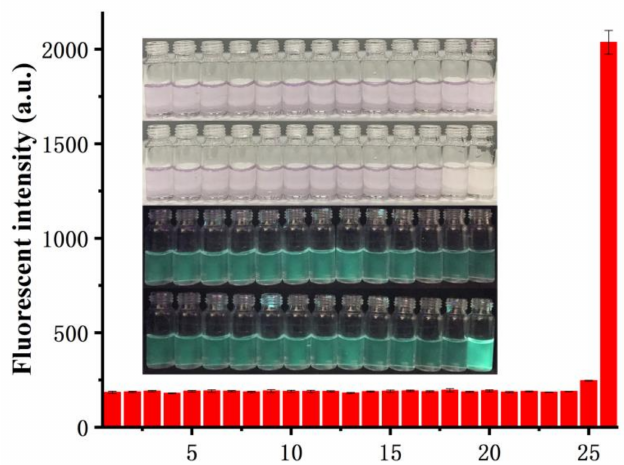
Figure 5. Fluorescence intensity changes of BPO-Py-Cl with SO 2 and other species. Inset: fluorescence changes of BPO-Py-Cl upon addition of 500 µ M SO 2 and other species under visible light and UV light (Ex = 365 nm). 1. BPO-Py-Cl , 2. Ala, 3. Arg. 4. Asp, 5. Glu, 6. Gly, 7. His, 8. Ile, 9. Leu, 10. Lys, 11. Met,